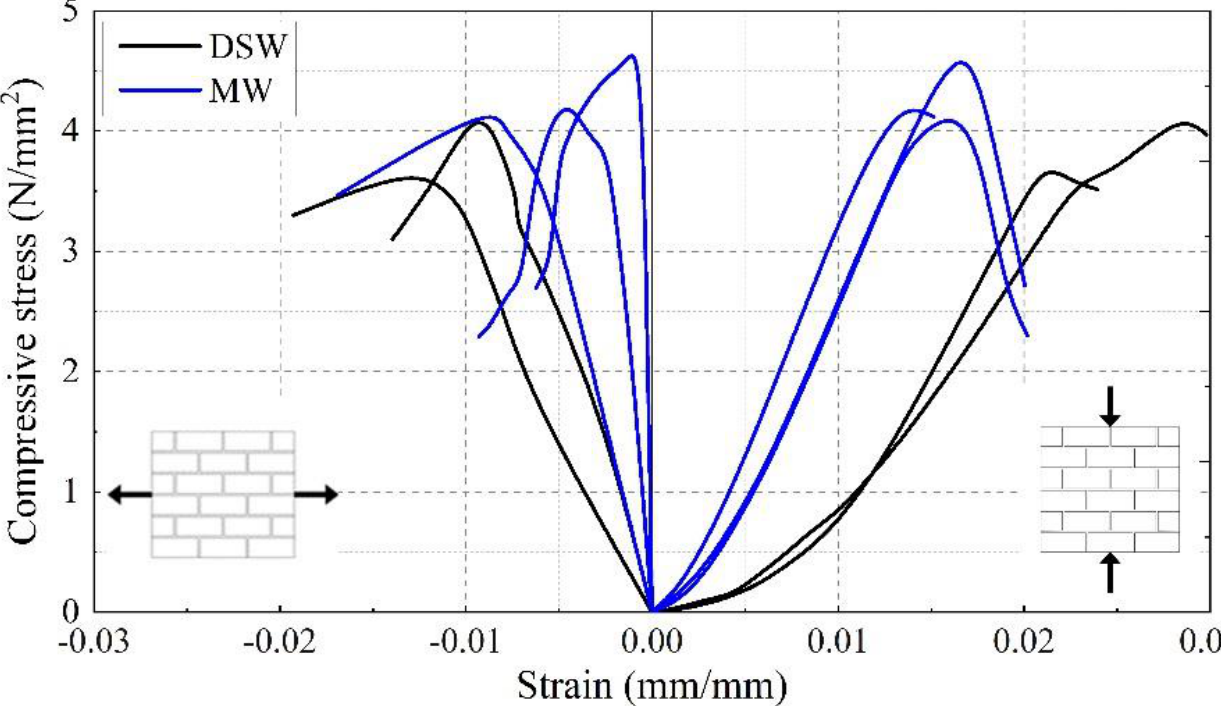
Figure 10. Stress – strain curves in compression of the wallettes with dry stack (DSW) and mortar Figure 10. Stress–strain curves in compression of the wallettes with dry stack (DSW) and mortar joints joints (MW).